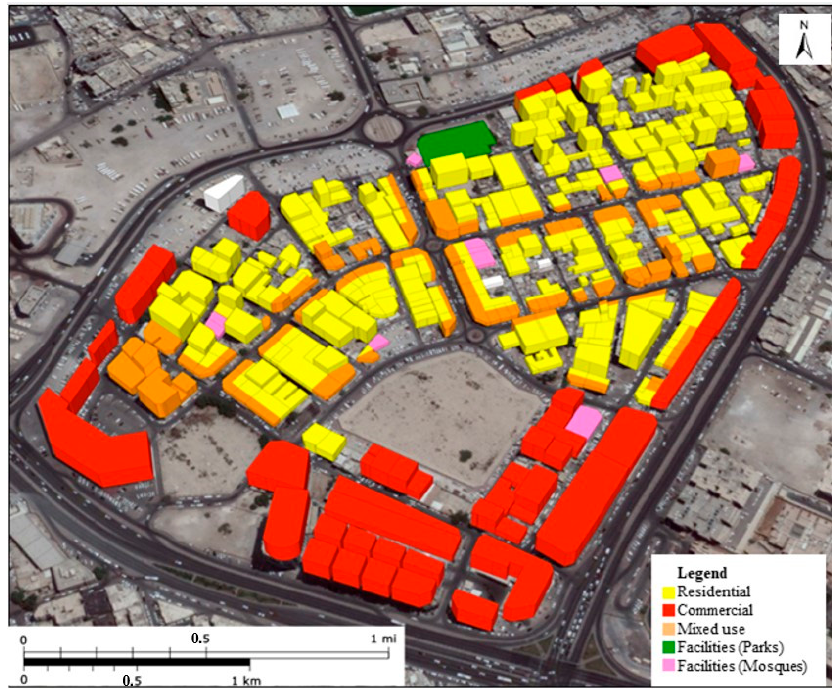
Figure 6. Existing land uses in the Al Ghanim district (Source: the Authors).